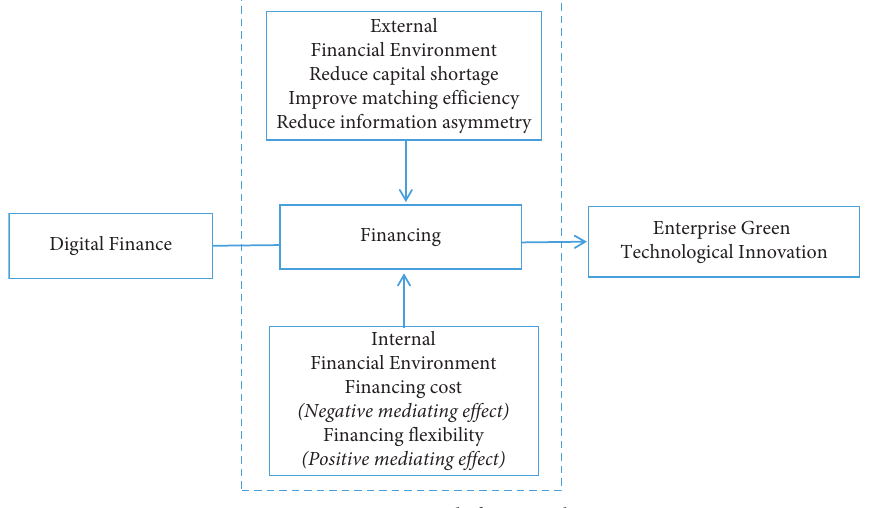
Figure 1: Research